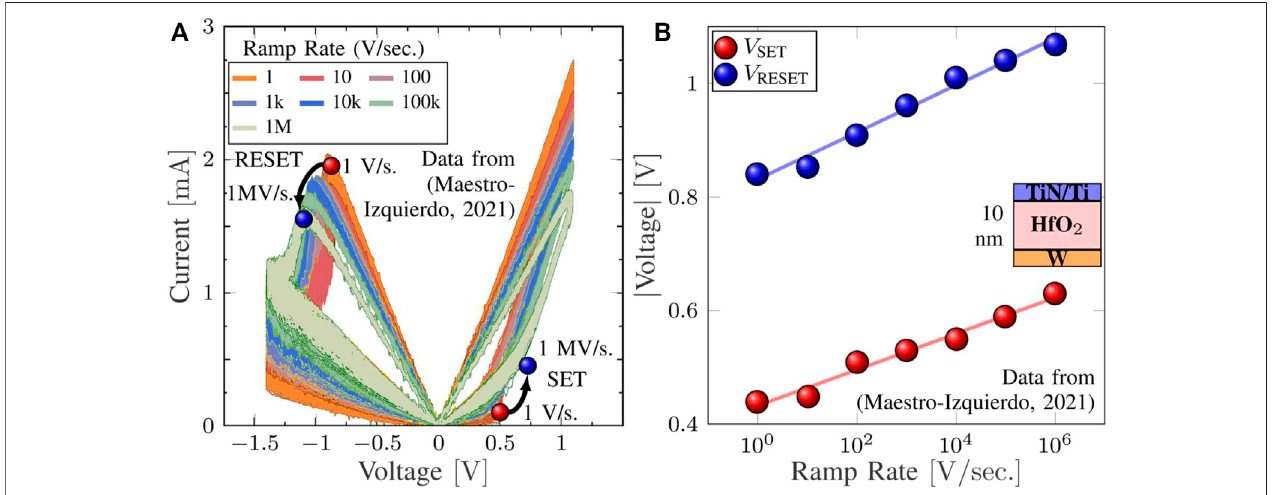
FIGURE 3 | (A) I-V loops measured on TiN/Ti//(10-nm) HfO 2 /W samples [63] for different RR (measured in V/sec.). Note that as the RR increases, the I-V lobes shrink and the SET and RESET voltages shift to higher absolute values. (B) The shifts of V SET and V RESET are plotted as function of RR and fi tted with Eq. 4